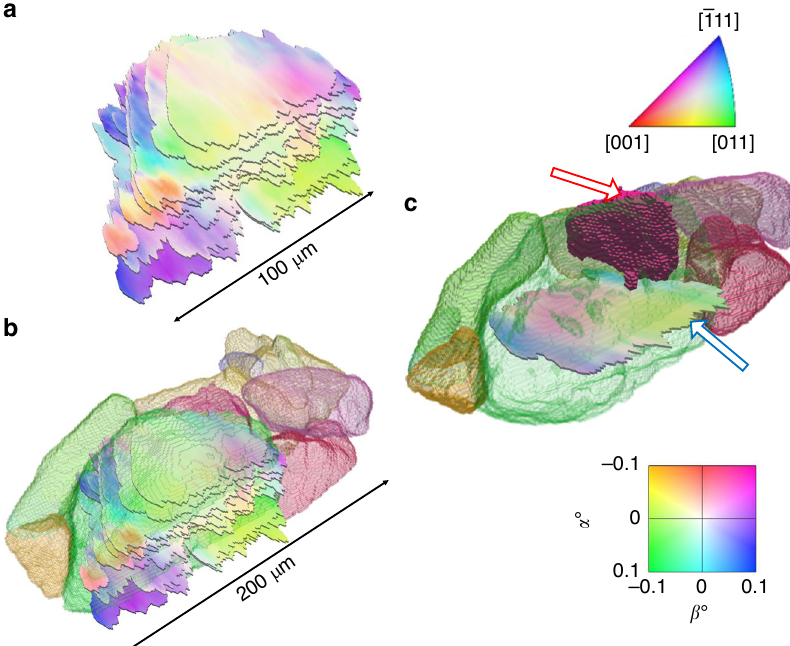
Fig. 4 Spatially Linking DCT and DFXM. ( a ) DFXM mosaicity scans, of the GOI, placed within the DCT reconstruction. ( b ) DFXM mosaicity scans, stacked to construct the 3D GOI. ( c ) Spatial location of combined mosaicity and elastic strain scan to be investigated in regards to the coherent twin. Combined mosaicity and elastic strain scan marked is marked by a blue/white arrow while the coherent twin is marked by a red/white technique, as determined by Poulsen et al., are 0.0057° and 10 − 4 , respectively 17 . Conducted at ESRF, beamline ID06, mosaicity (lattice curvature) scans provided 2D spatial information of the lattice curvature. Multiple mosaicity scans taken as the sample was translated vertically were stacked to provide a 3D dataset of